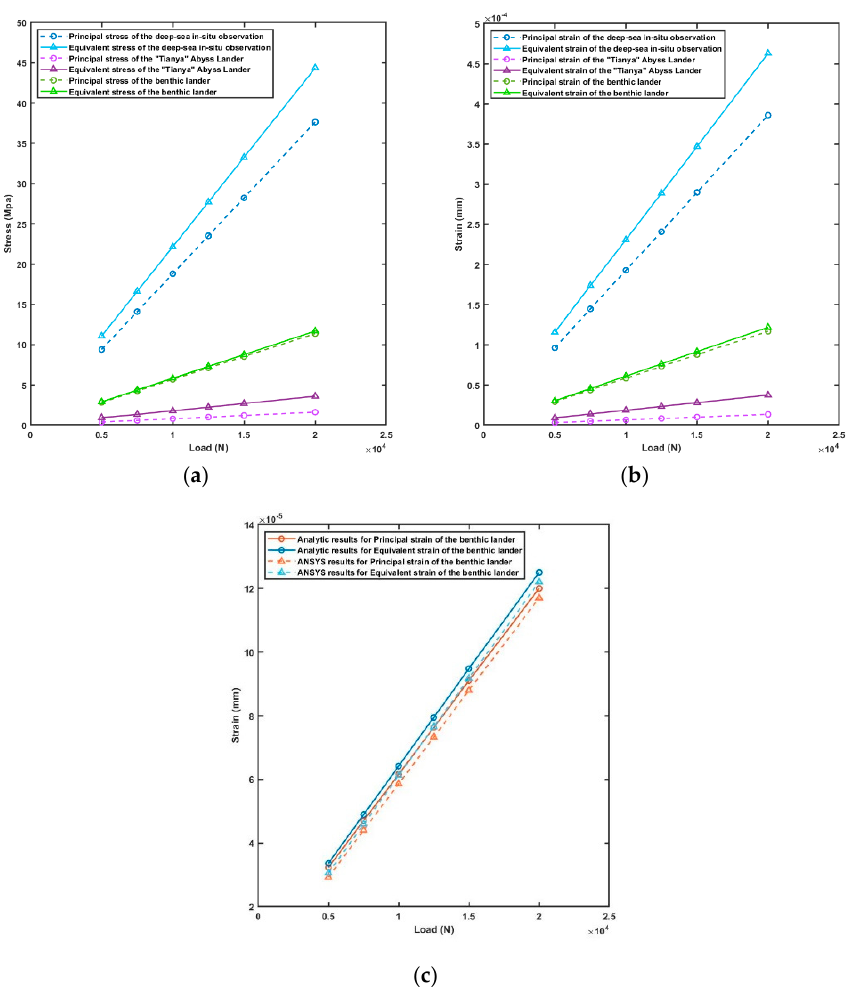
Figure 7. Stress and strain variation with static load for three frames: ( a ) the relationship between stress and static load; ( b ) the relationship between strain and static load; ( c ) the comparison